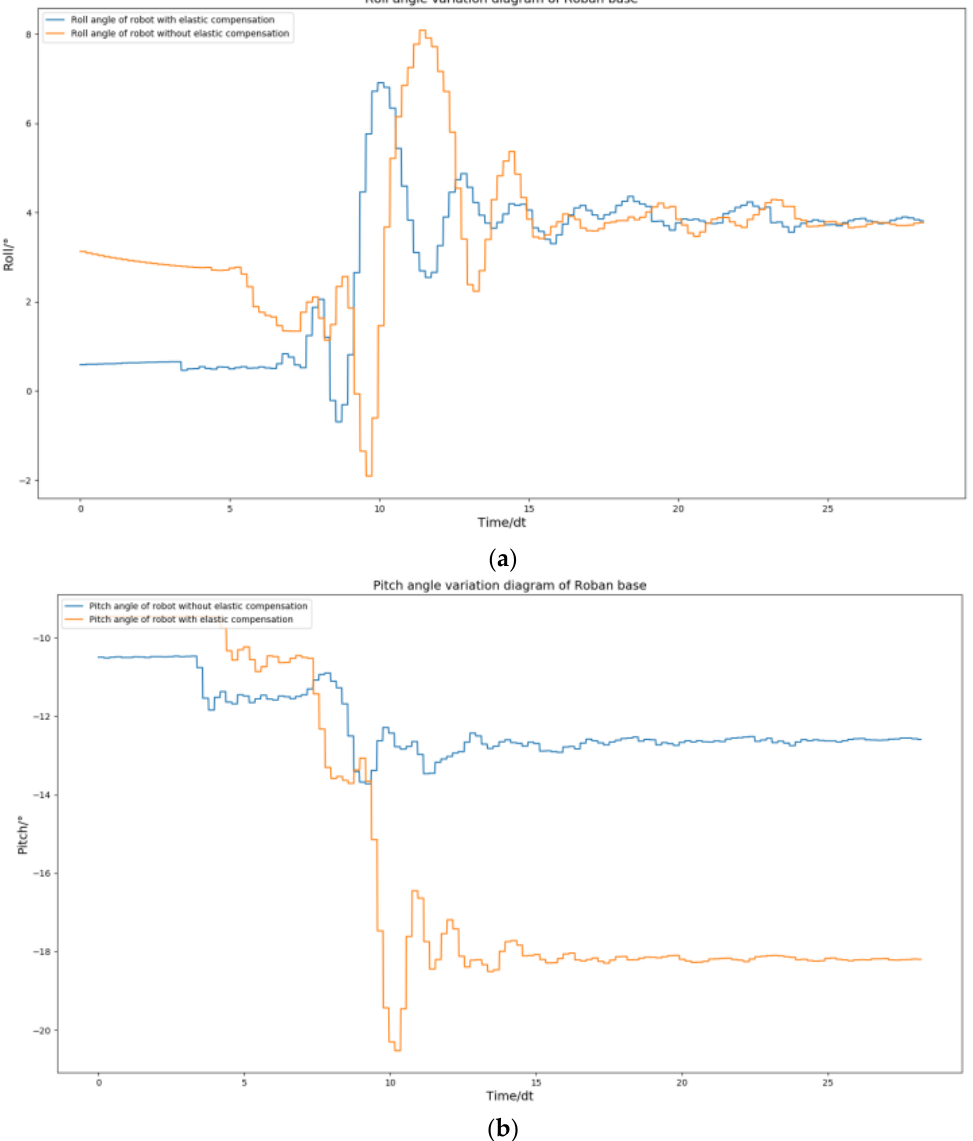
Figure 26. The Roban robot performs a side swing motion. We obtained the curve comparison diagram of roll angle and pitch angle of the robot with and without spring compensation in this process. ( a ) Comparison diagram of roll angle change of robot with and without spring Compensation. ( b ) Comparison diagram of pitch angle change of robot with and without spring compensation.